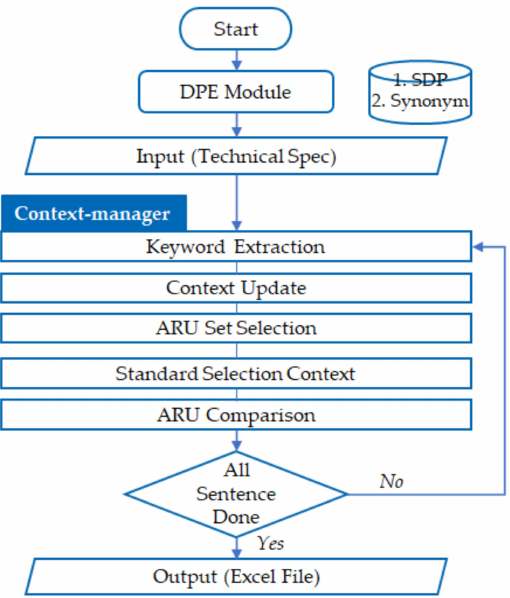
Figure 15. Flowchart of the DPE